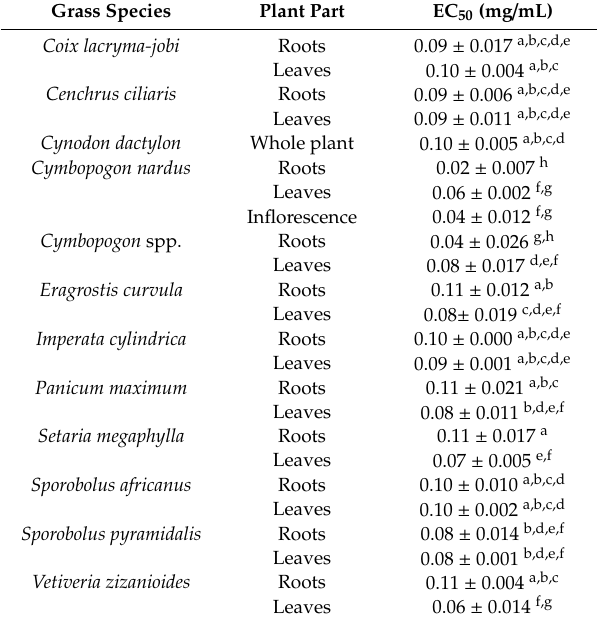
Table 3. DPPH (1,1-Diphenyl-2-picrylhydrazyl) radical-scavenging activity (EC 50 ) of grasses evaluated for their therapeutic potential in South African traditional medicine. Values indicate mean ± SE, n = 3. Di ff erent letter(s) associated with EC 50 indicate significant di ff erences at the 5% level of significance. Ascorbic acid (positive control) = 0.025 ±